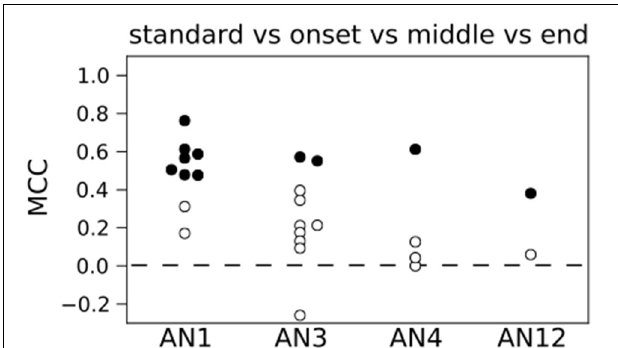
FIGURE 4 | Count based decoding of stimuli in single neurons. A classification of the four stimuli is in 11 (filled circles) out of 25 neurons significantly better than a classification based on randomized counts. The distribution of MCC values of all 25 neurons differs significantly from the MCC distribution of the classifiers that are based on randomized counts ( p < 0 . 05, one-sided Wilcoxon rank-sum test). Dashed line represents chance level based on randomized